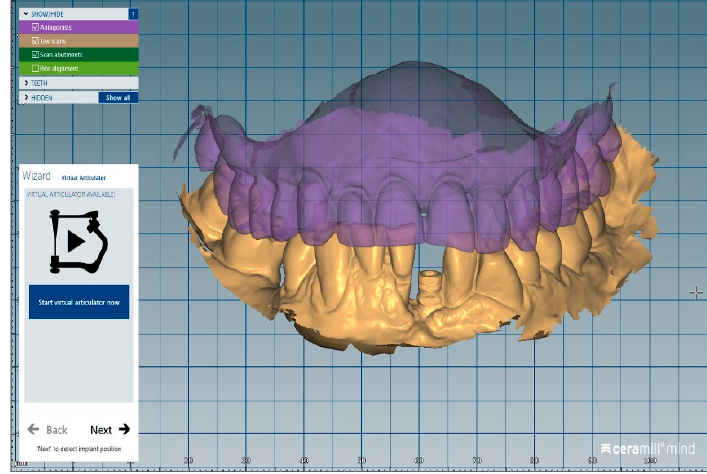
Figure 2. STL file of the analog transfer screwed in the implant. 5. Remove the analog transfer from the mouth and mount it in the transfer accessory. 6. Scan with an intraoral scanner the analog transfer together with a sufficiently large area of the chuck, which will allow subsequent indexing in the CAD software; export as an STL file (Figure 3).